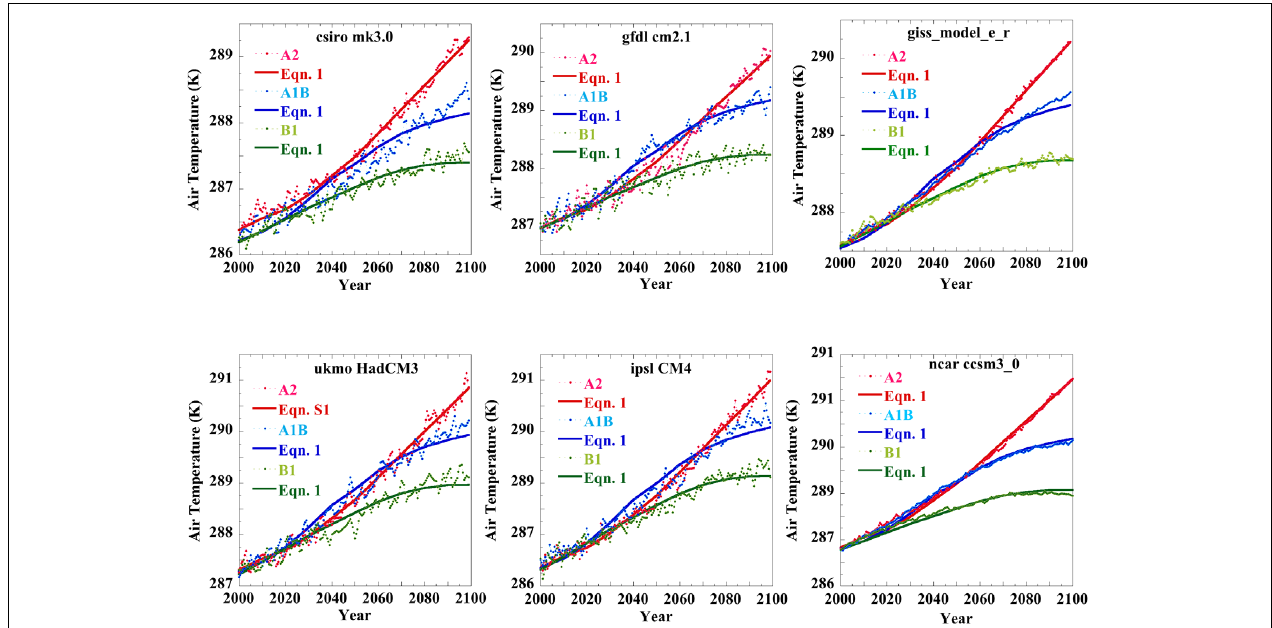
FIGURE 2 | CMIP3 SRES air temperature projections and their equation 1 emulations: (colored points), SRES B1, A1B, and A2 scenario global air temperatures projected by representative CMIP3 GCMs, and; (colored lines), the same scenarios emulated using equation 1. The equation 1 coefficients for the individual emulations are given in Table S4-1 , Table S4-2 , and Table S4-3 of the Supporting Information . Figure S5-1 shows the emulation coefficients are highly correlated among the tested models ( R = 0.98). The 4AR SRES anomalies were obtained from the IPCC electronic